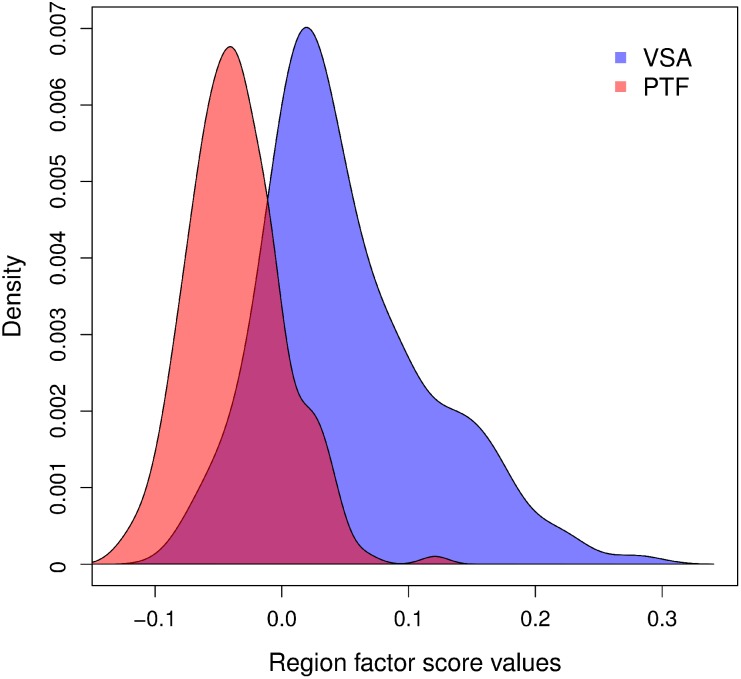
DiCA analysis: regions factor scores histogram.We plot the histogram of the factor score values–obtained for the 394 regions by the DiCA analysis–as a function of the number of regions a priori assigned to the VSA (blue) or the PTF (red) ring.